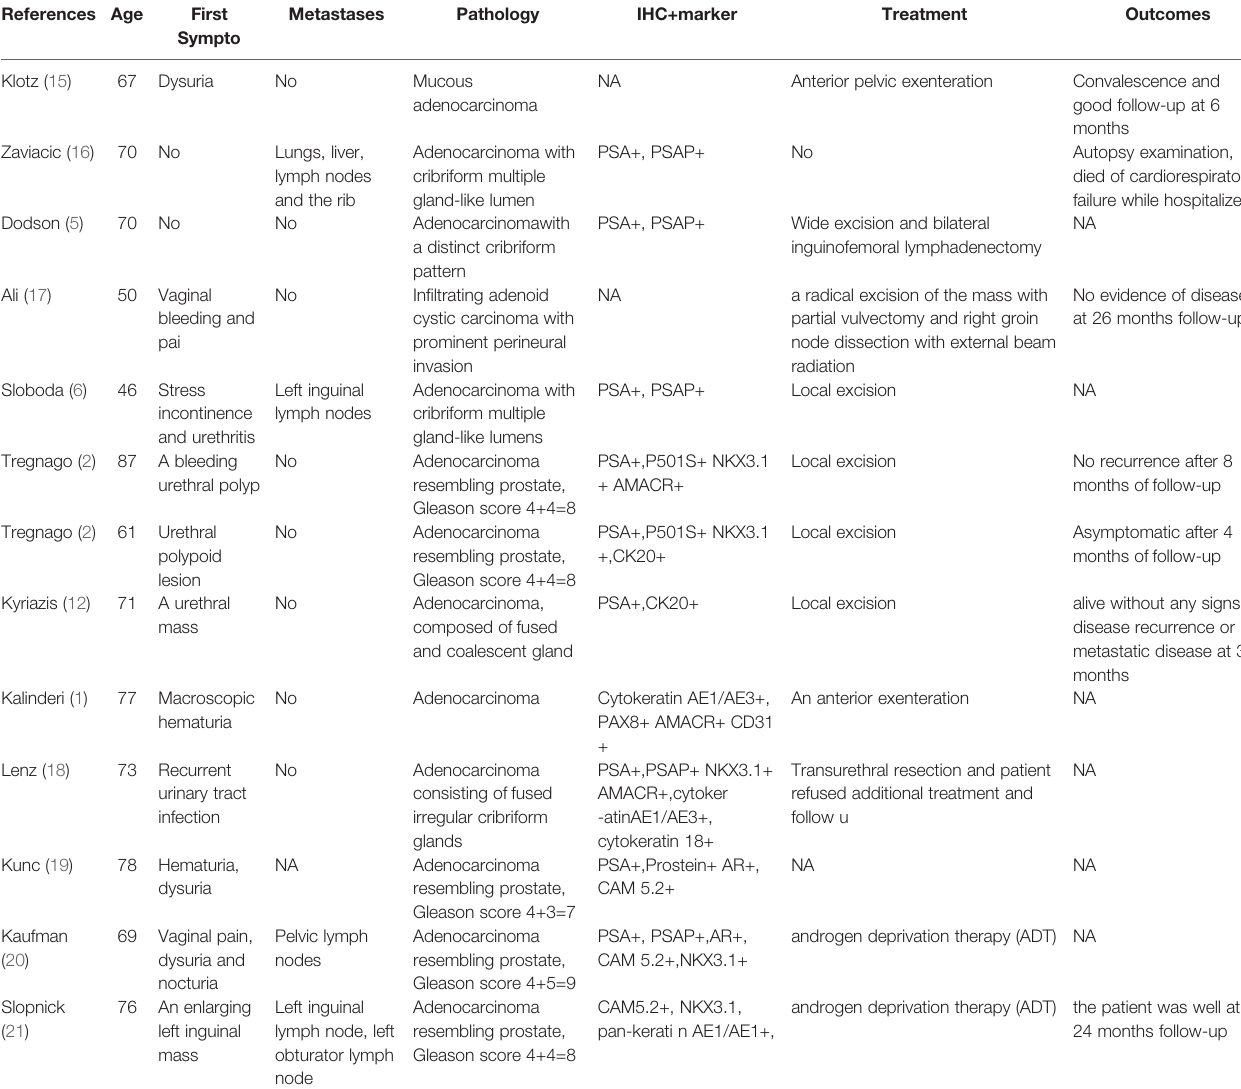
TABLE 1 | Summary of cases of Skene's gland carcinoma reported to